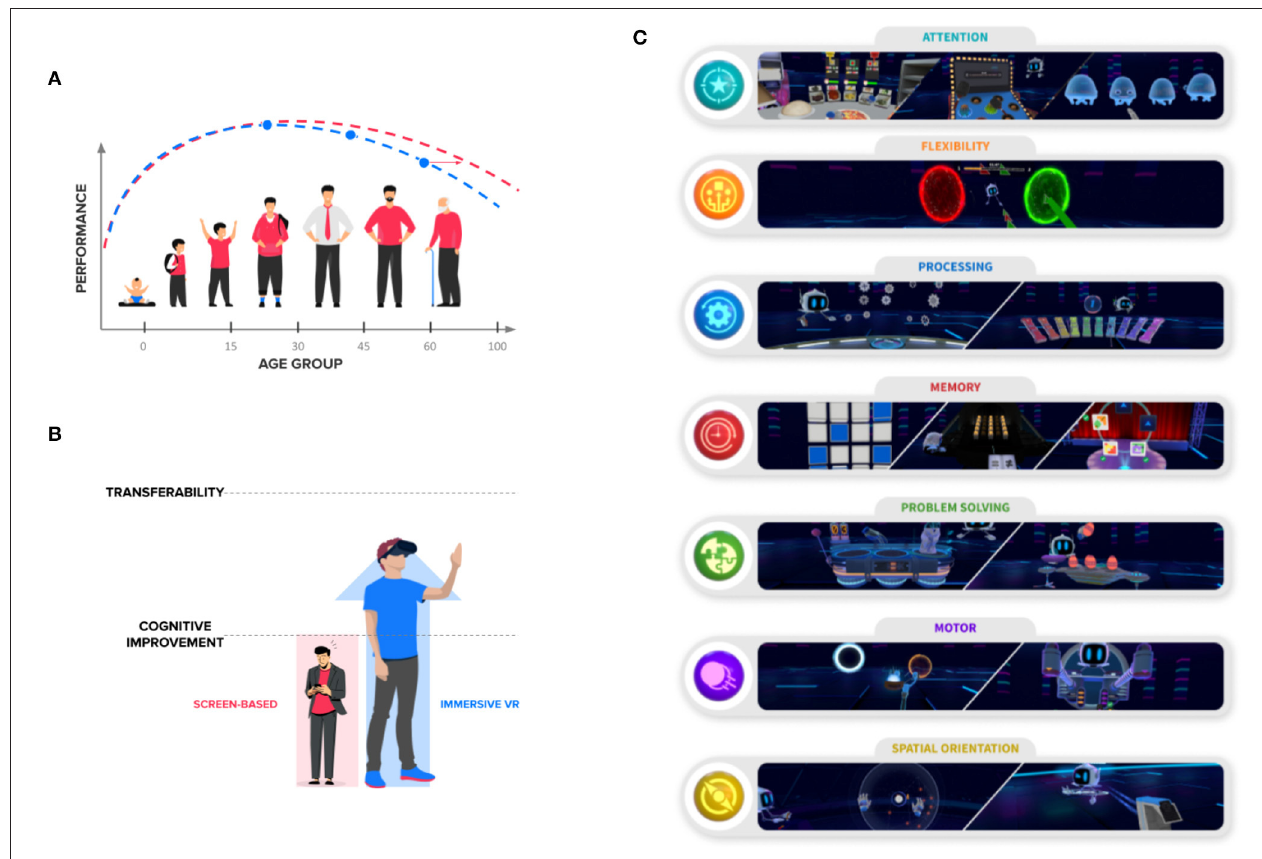
FIGURE 1 | Enhance VR offers a library of cognitive exercises in virtual reality. (A) Cognitive abilities change across the lifespan of an individual. Cognitive training solutions, together with physical exercise and a healthy balanced diet, have shown potential improvement in the cognitive abilities of elderly. (B) Screen-based cognitive training solutions have shown potential improvement in the trained cognitive abilities, but the effects on global cognitive functioning and activities of daily living are still to be determined. Virtual reality systems present the user with an embodied experience of cognitive exercises, which can potentially increase the possibility of transfer of benefits. (C) The Enhance VR exercises span across seven cognitive categories (and their respective subcategories). Namely, attention, cognitive flexibility, information processing, memory, problem-solving, motor control, and spatial orientation. The latter being inherent to IVR